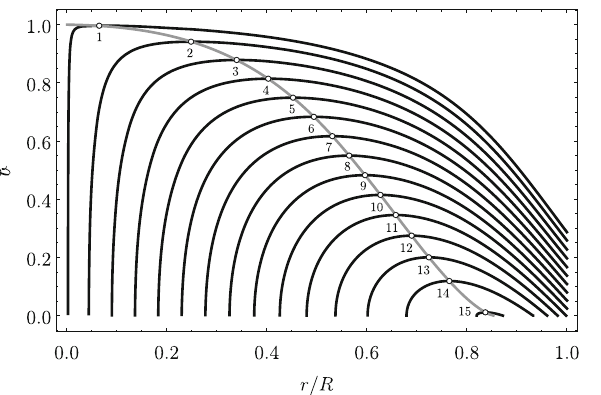
is given by the corresponding position of b max on the right plot which shows the local maxima of local trapping efficiency b max for the same values of the parameter R / M